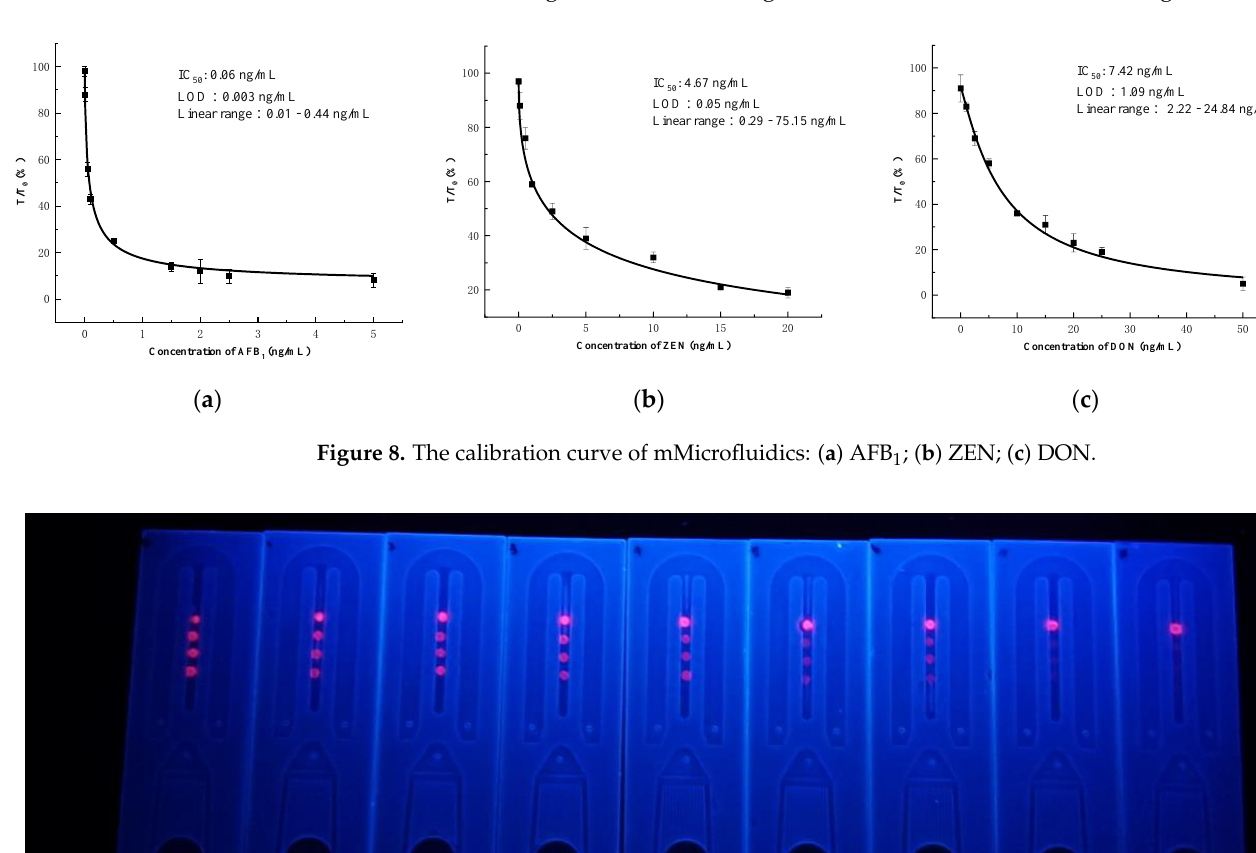
( d ) Figure 7. The coating antigens amount: ( a ) AFB 1 ; ( b ) ZEN; ( c ) DON; ( d ) Chicken IgY. 3.5. Sensitivity of the Microfluidics Using 0.01 M PBS, different concentrations of AFB1, ZEN, and DON were produced and utilized to assess the detection performance of microfluidics. The visible limit of de- tection (vLOD) for the eye was defined as the sample concentration at which the fluores- cence disappeared from the test area. A fluorescence reader was used to measure color intensity in quantitative assays. The calculated lower limit of detection (cLOD) was de- fined as the concentration at 10% inhibition (IC10) of the standard curve. The linear range was defined as the concentration at the standard curve IC20 to IC80. T/T0 was defined as the ratio of the fluorescence intensity of the test area of the standard sample to the fluo- rescence intensity of the blank sample. After determining the T/T0 value of the unknown sample using a fluorescence reader, the concentrations of AFB1, ZEN, and DON were cal- culated. The results for AFB1 are shown in Figure 8a: the AFB 1 calibration curve was y =